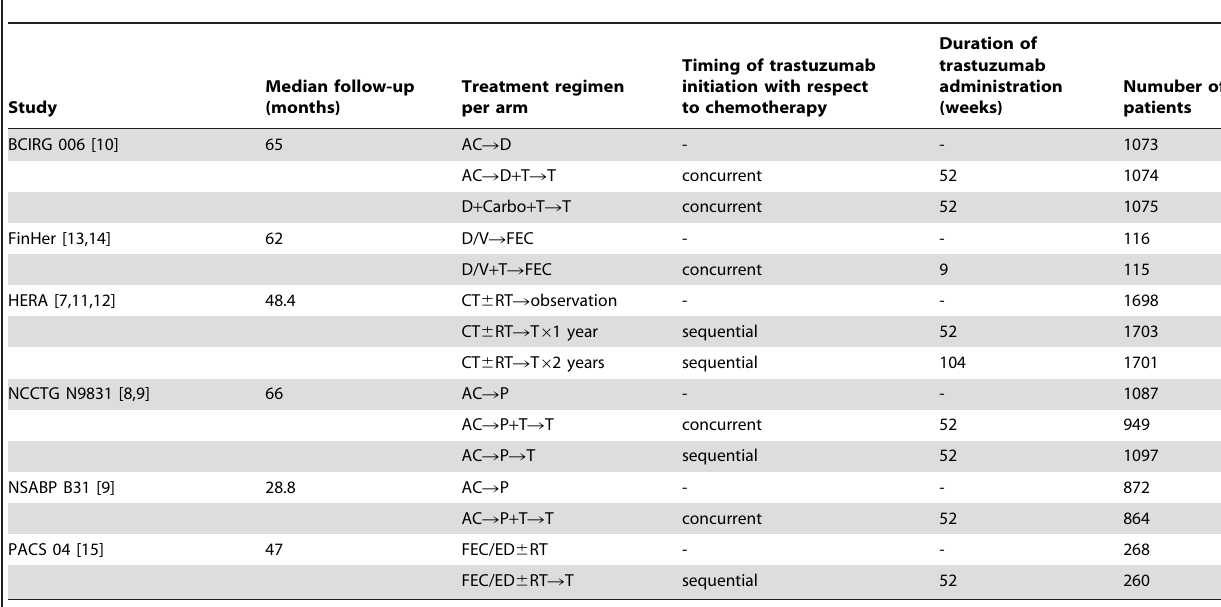
Abbreviations: BCIRG, Breast Cancer International Research Group; AC, doxorubicin and cyclophosphamide; D, docetaxel; T, trastuzumab; Carbo, carboplatin; FinHer, Finland Herceptin H study; V, vinorelbine; FEC, fluorouracil, epirubicin and cyclophosphamide; HERA, Herceptin H Adjuvant trial; CT, chemotherapy; RT,